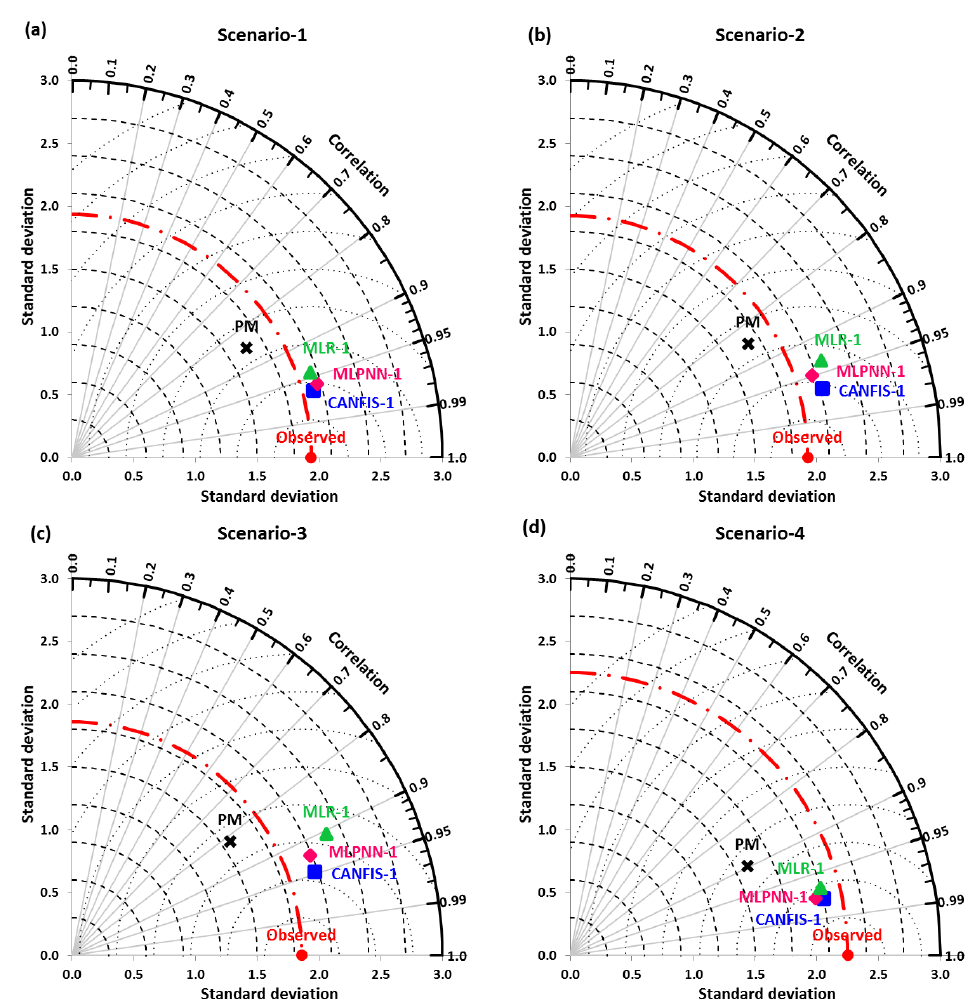
Figure 12. Taylor plot of observed and estimated monthly evaporation obtained by the CANFIS-1, MLPNN-1, MLR-1, and PM models in ( a ) scenario-1, ( b ) scenario-2, ( c ) scenario-3, and ( d ) scenario-4 during the testing period at Nagina station.